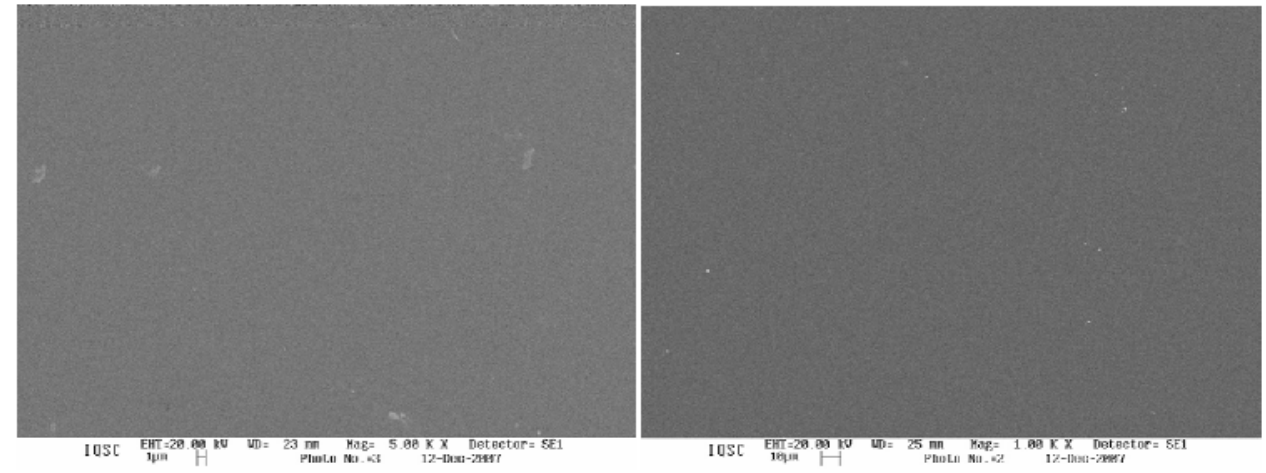
Figure 2. Low molecular weight chitosan (left) and high molecular weight chitosan (right) SEM (Scanning Electron Microscope) images.